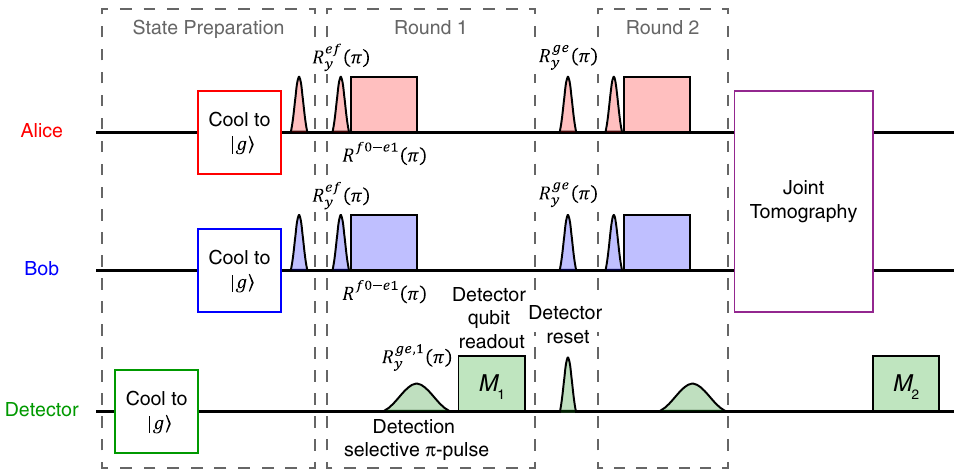
FIG. 12. Detailed remote entanglement protocol pulse sequence. The remote entanglement protocol began with state preparation, where the three qubit-cavity systems were initialized in the desired state by cooling and single-qubit rotations. Then, the first of the two rounds of the protocol was performed. The qubits were entangled with flying single photons by a CNOT-like operation, which then interfered on the hybrid and were detected by a selective π -pulse on the detector qubit. A π -pulse was performed on both Alice and Bob to remove the unwanted j ee i state and on the detector to reset it. Next, the second round of the protocol was performed, followed by joint tomography to measure the state of Alice and Bob. The measurement outcomes from the two rounds of photon detection, M 1 and M 2 , were used to post-select successful trials for the tomographic analysis. The entire protocol was repeated with T than the T 1 time of any of the